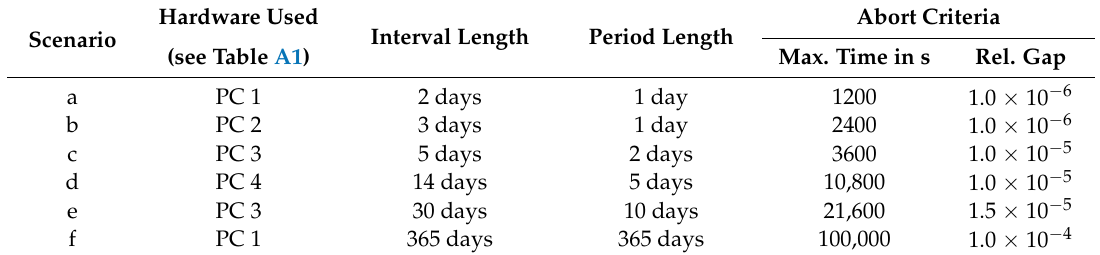
Table 1. Temporal configurations of the scenarios and abort criteria for